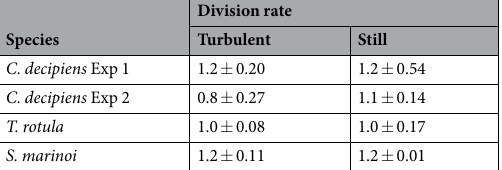
Table 2. Division rates calculated as the first derivative of the steepest portion of the growth curve. Average ± standard deviation is reported (n =